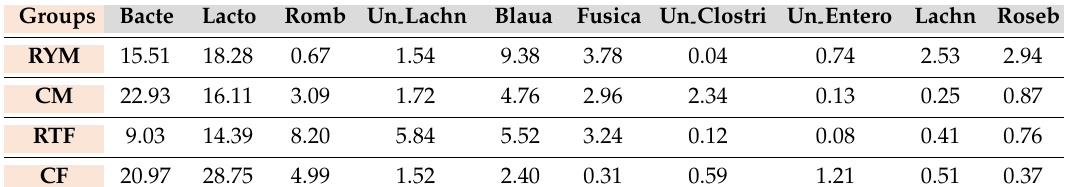
Table 3. The top ten bacteria with the highest abundance at the genus level.